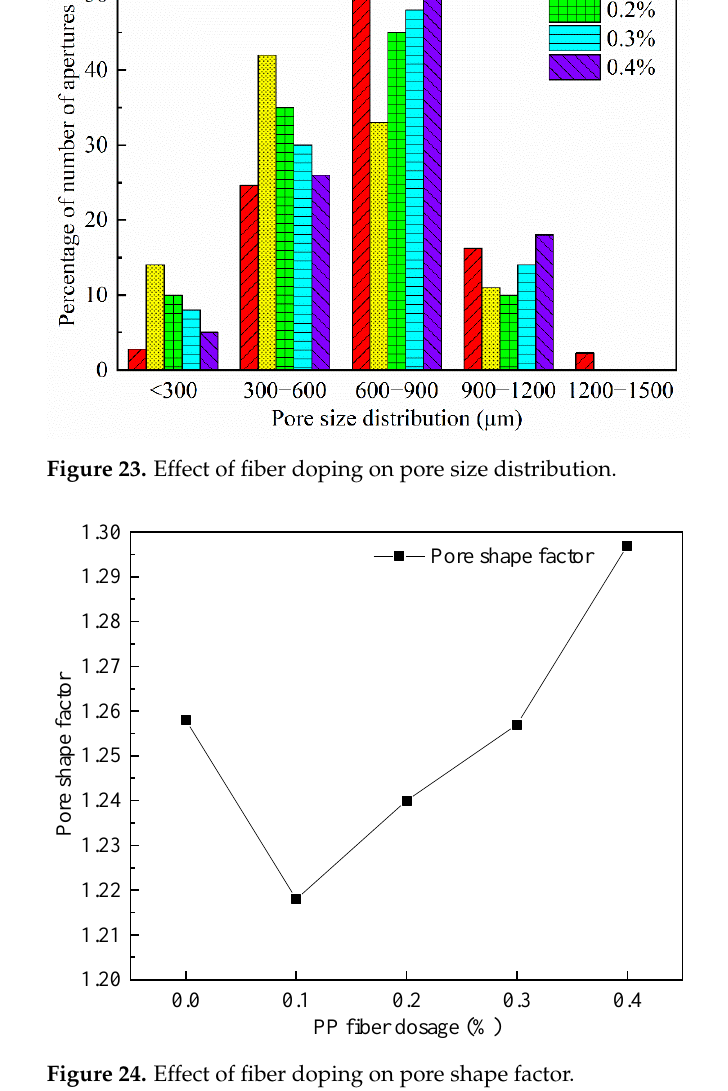
Figure 24. Effect of fiber doping on pore shape factor.